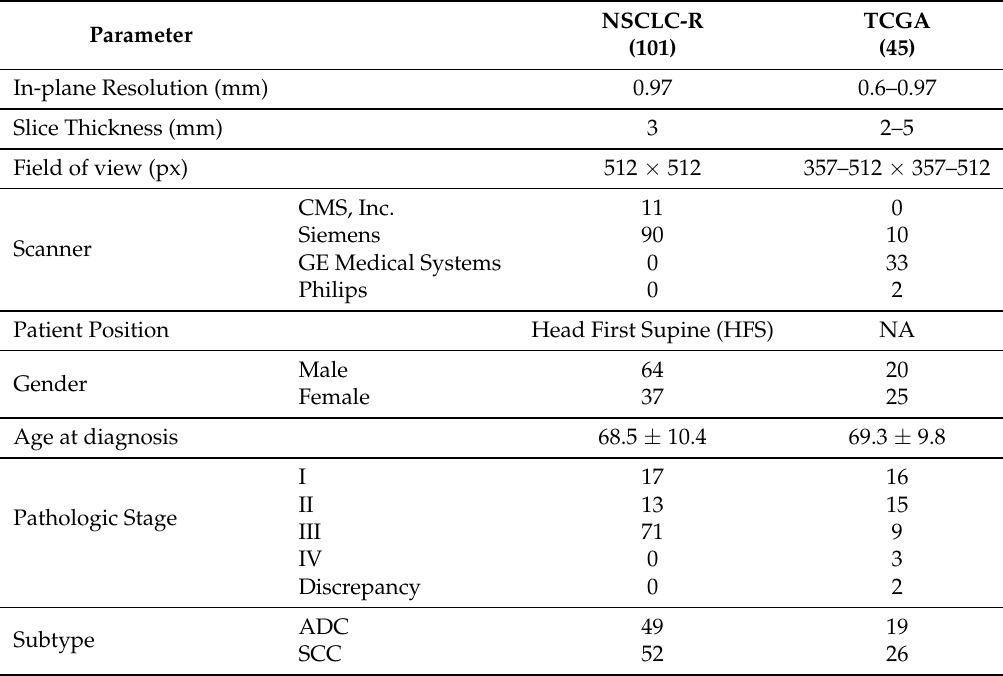
Table 2. Summary of imaging parameters, demographics, and pathologic information of CT images used in this